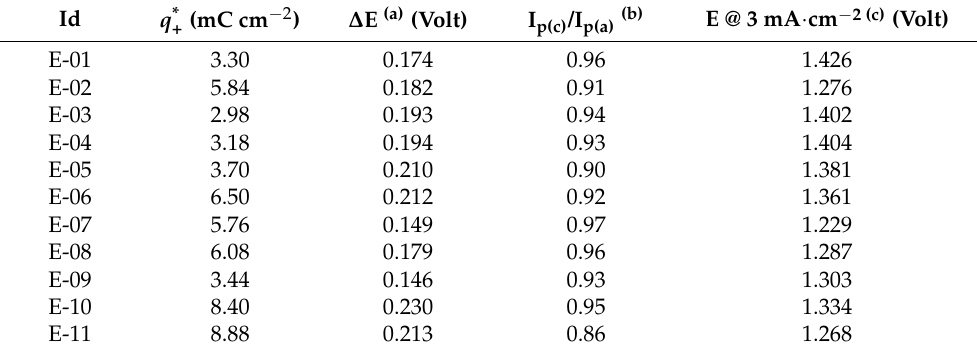
Table 2. Electrochemical data.